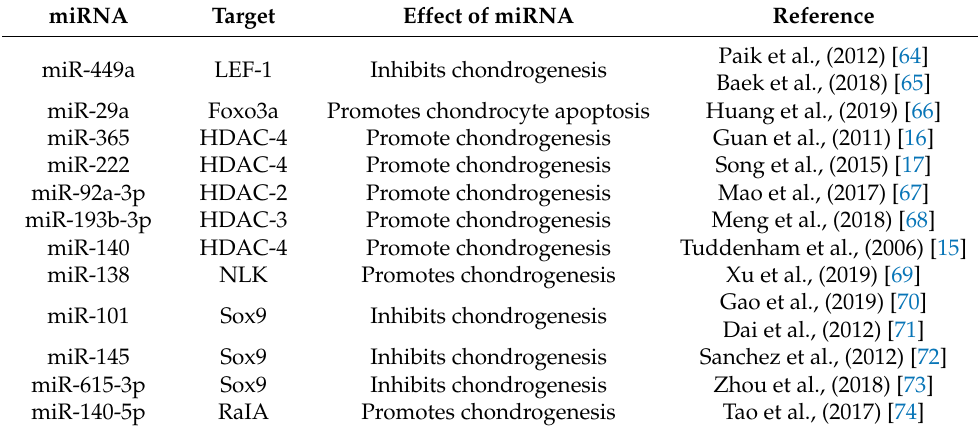
Table 3. miRNAs targeting Wnt pathway transcription factors and associated proteins in the patho- genesis of